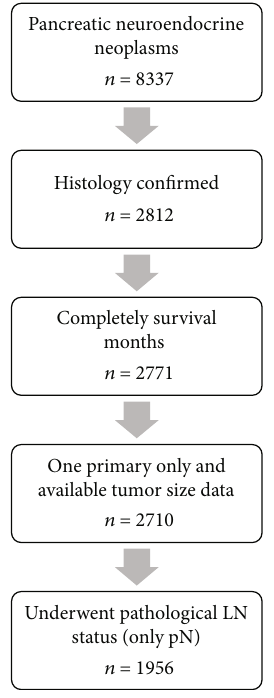
Figure 1: Flowchart of the patients selection process. A total of 8337 cases of pancreatic neuroendocrine neoplasms (PNEN) from SEER database were screened and 1956 cases were included in the fi nal